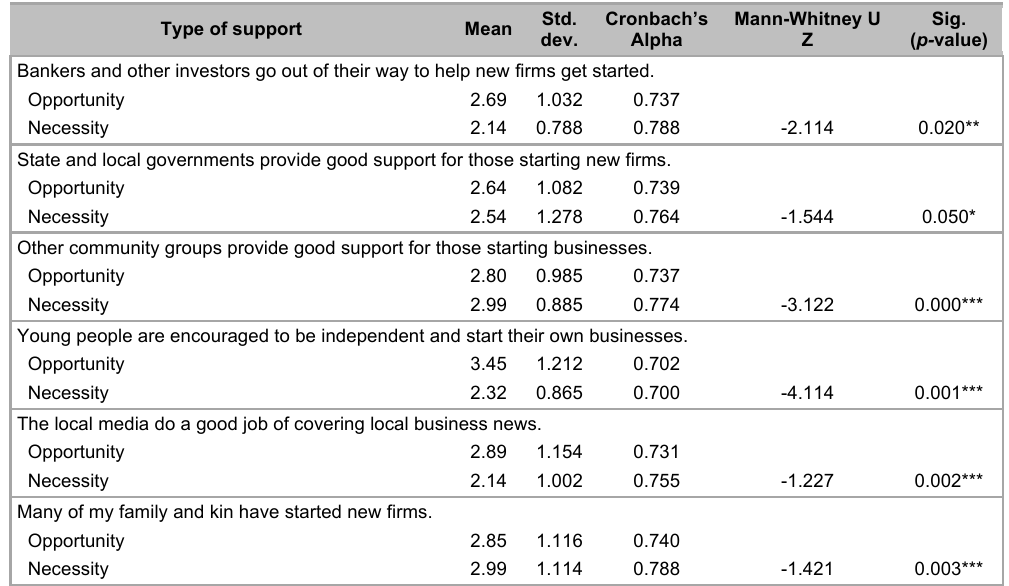
Statistics for climate support perceptions between NDE (n =102) and ODE (n =